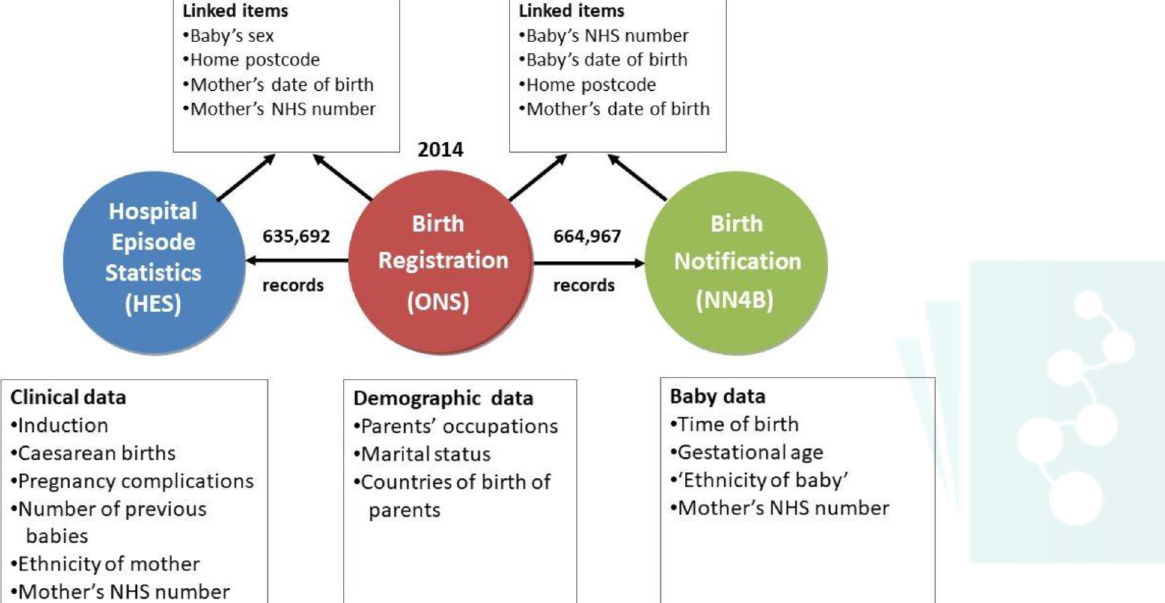
Figure 1: Overview of datasets for England used in the study, showing types of data held within each dataset and how they were